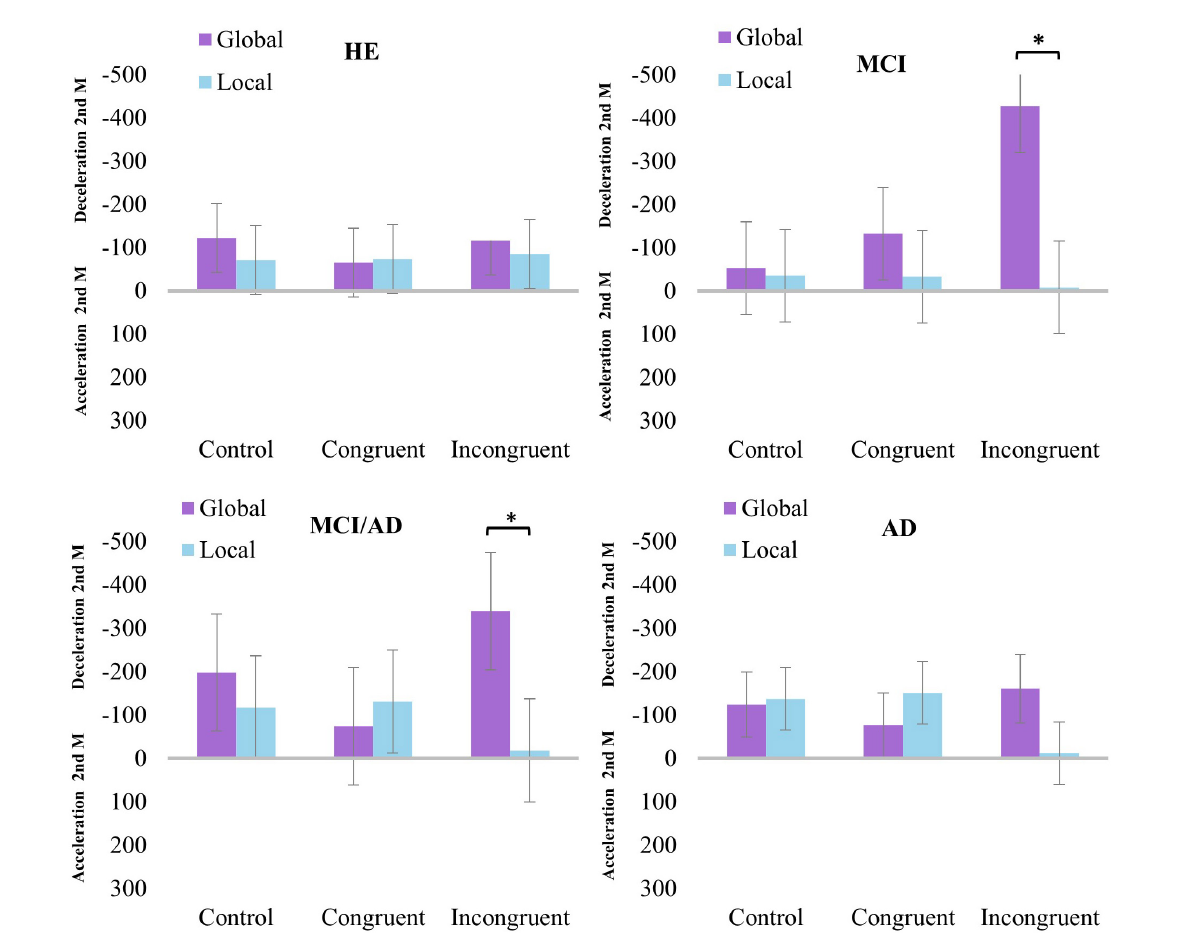
FIGURE4 Results of pairwise comparisons for Group × Congruency × Task comparing the I 1 − 2 RpTs index between the global and local tasks. ∗ Statistically significant differences ( p < 0.05). Error bars show the standard error of the mean. Note that for the sake of clarity, negative values in the Y -axis are represented pointing